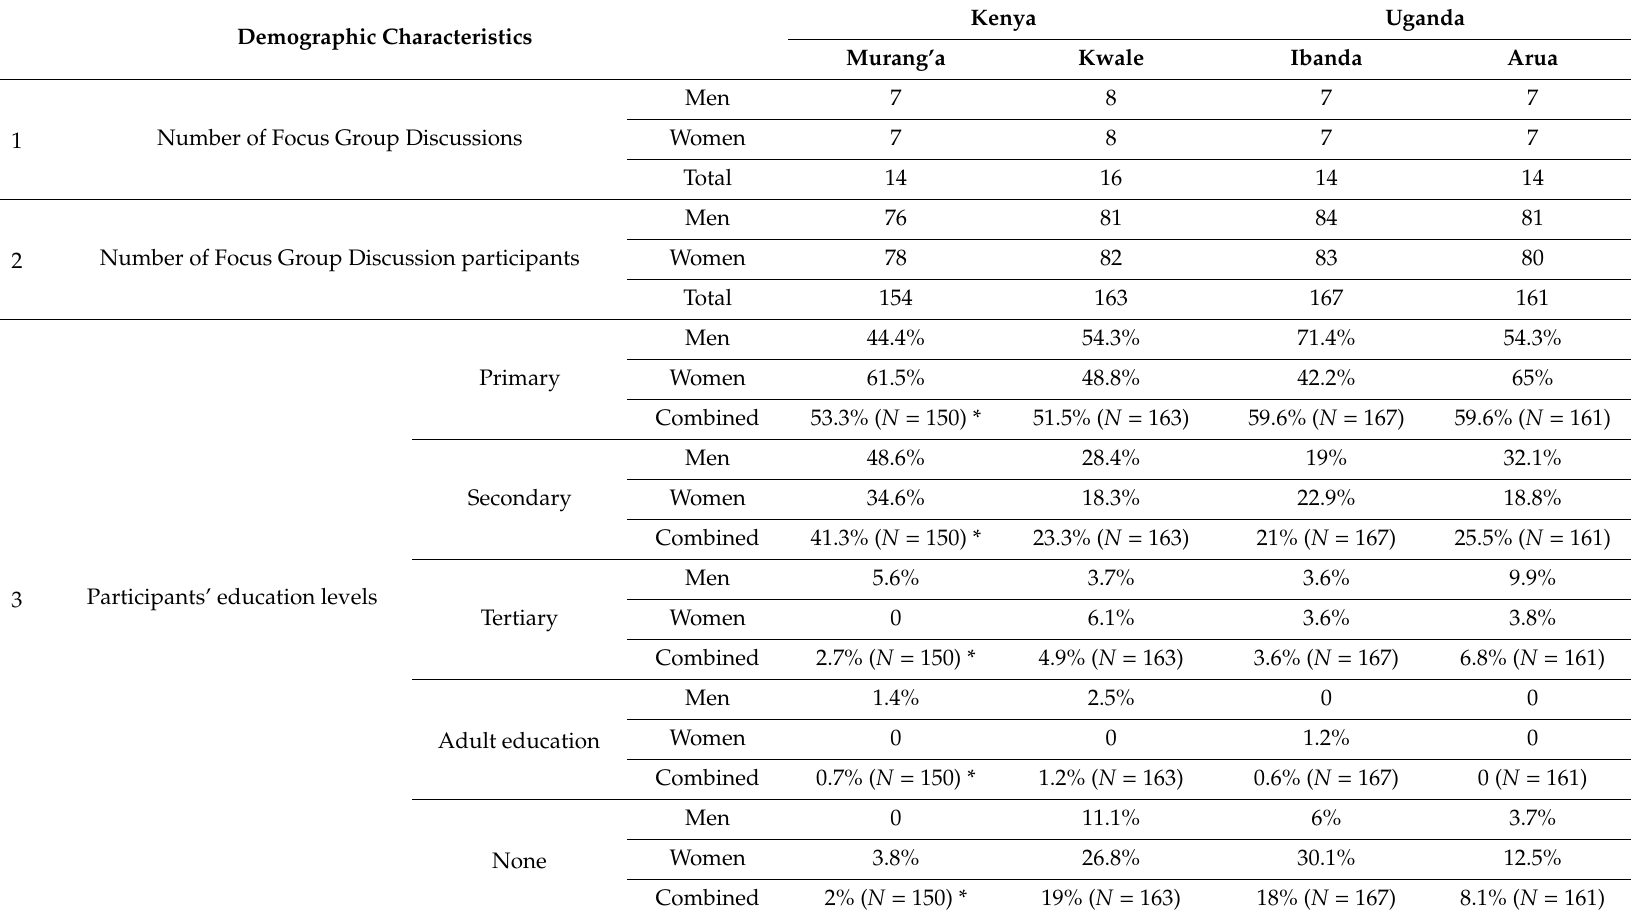
Table 1. Demographic